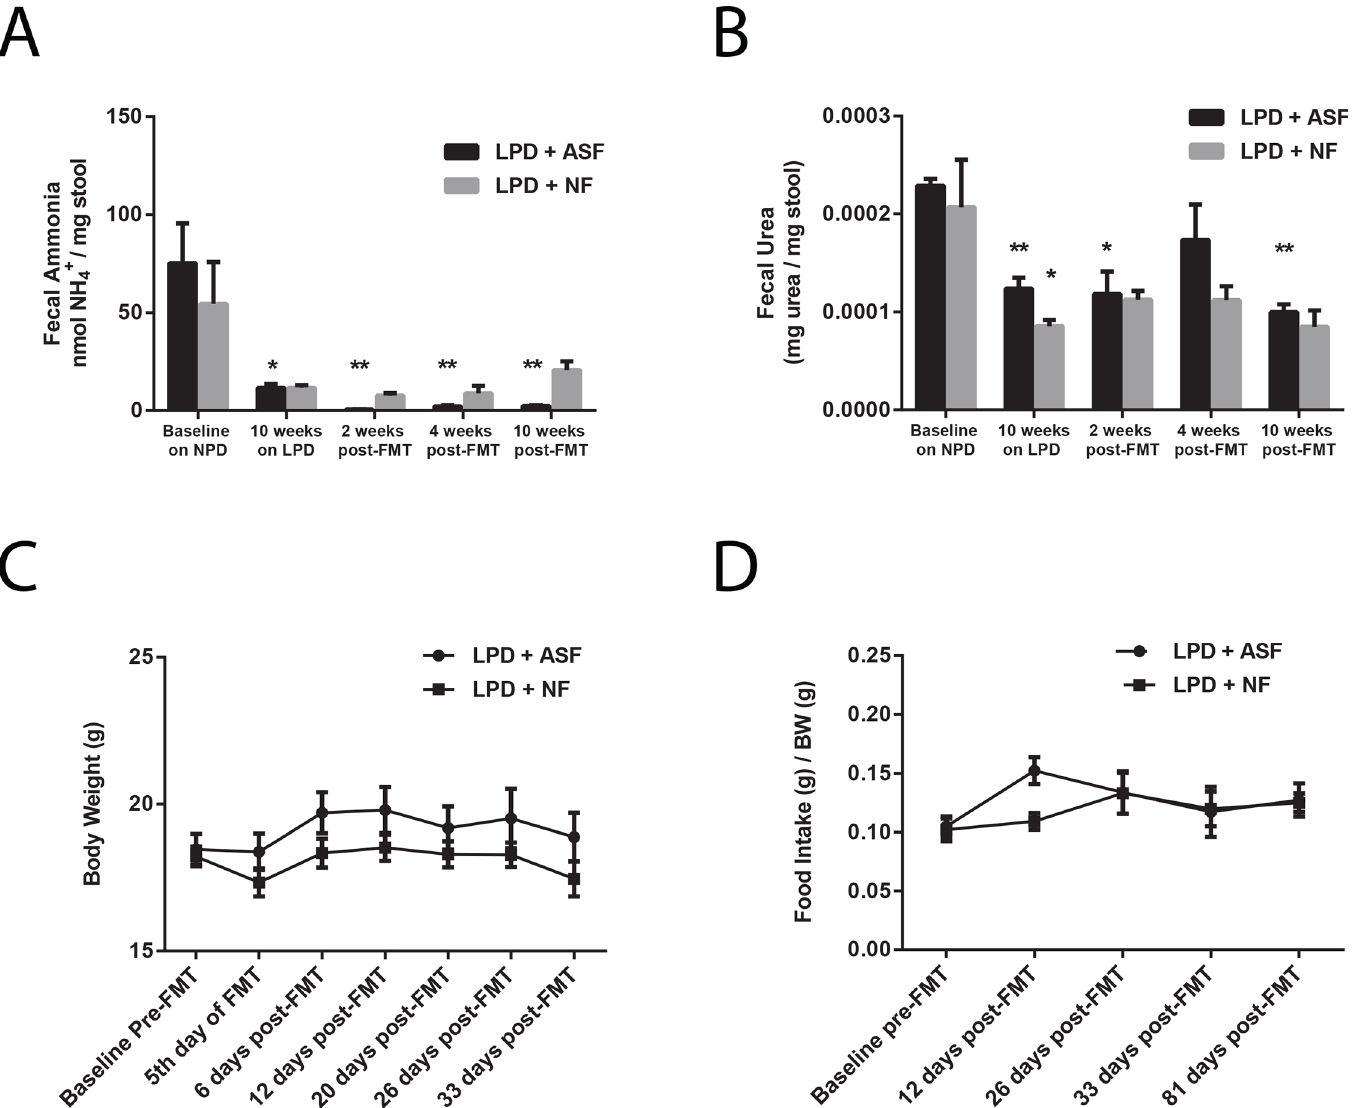
Fig 5. ASF transplantation alters colonic urea nitrogen recycling without significantly affecting host physiology. (A) ASF transplantation reduces fecal ammonia below the level achieved by the LPD alone (n = 4 – 5 per group, * p < 0.05 compared to baseline, ** p < 0.01 compared to 10 weeks on the LPD). (B) No difference in fecal urea level between ASF- and NF-transplanted mice (n = 2 – 5 per group, * p < 0.05 compared to baseline, ** p < 0.01 compared to baseline). No difference in (C) body weight or (D) food intake between ASF- and NF-transplanted mice (n = 5 per group). Values represent mean ± SEM. Significance determined by two-tailed Student ’ s